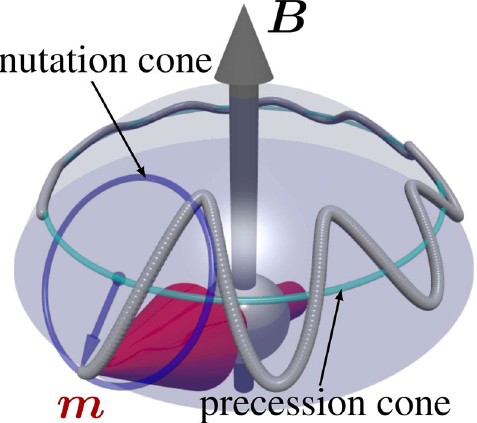
Figure 1. Schematic figure of the atomistic magnetic moment evolution effected by magnetic inertia. Without inertia and damping, the out-of-equilibrium magnetic moment m (red arrow) precesses around an effective magnetic field B (grey arrow), represented by a bright blue trajectory. Magnetic inertia, however, results in a precession around the angular momentum axis (dark blue line), that moves along the bright blue line. The resulting, superimposed trajectory (grey line) of the magnetic moment shows nutation. Since damping and inertia exists on different time scales, only the damping of the nutation but not the damping in effective magnetic field direction is